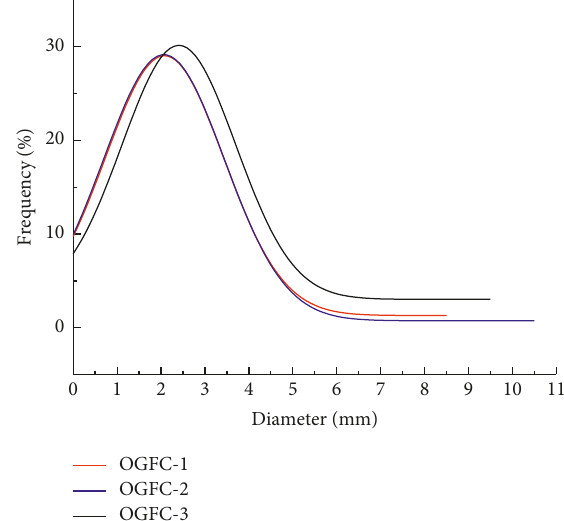
Figure 7: Frequency distribution function of the void diameter of three kinds of specimens.